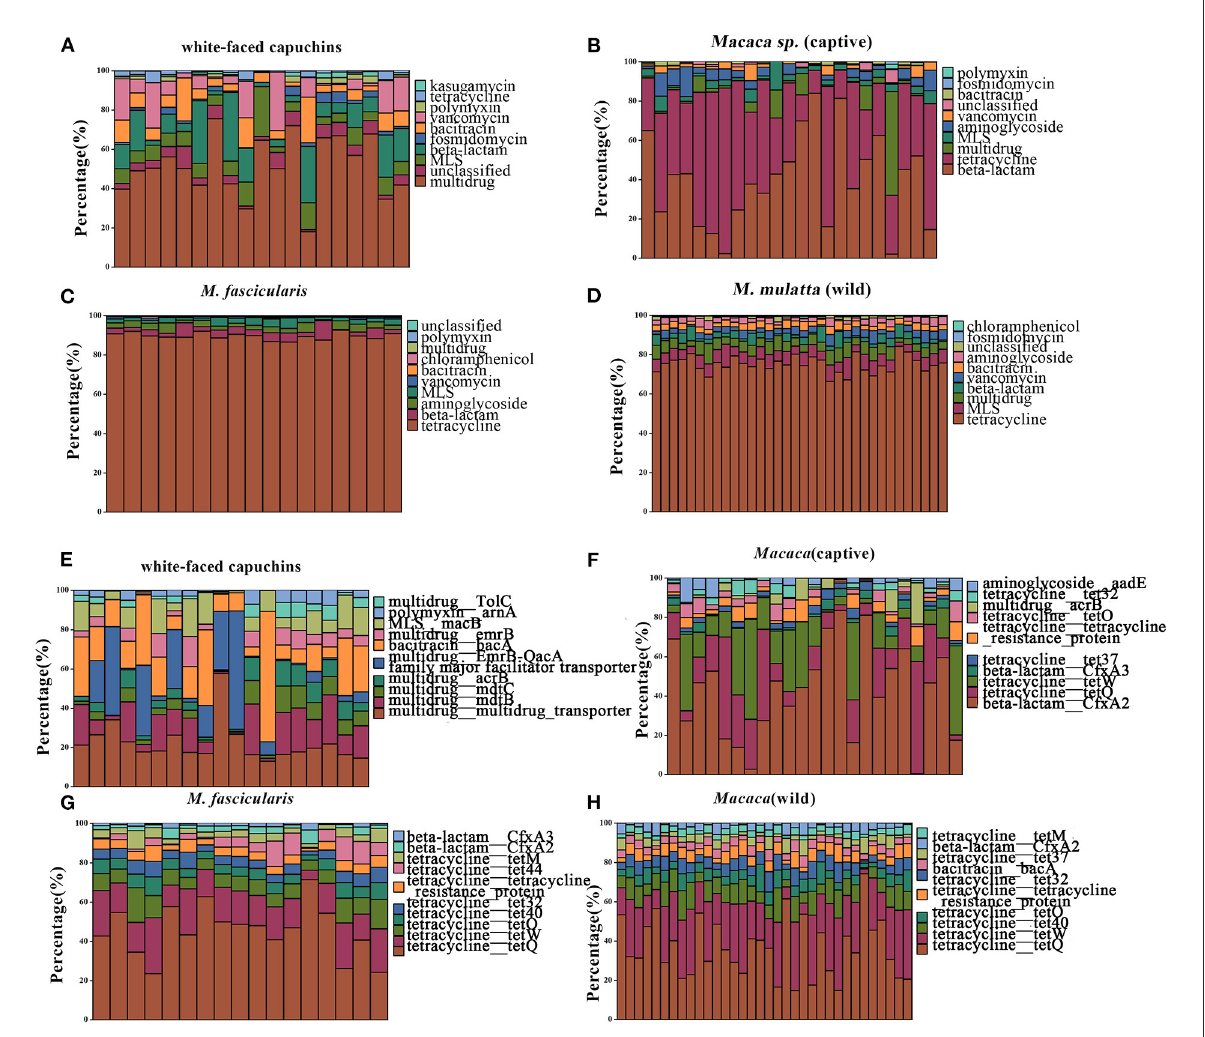
FIGURE4 Relative abundances of top 10 type and subtype ARGs. (A) The top 10 antibiotic resistance class of white-faced capuchins. (B) The top 10 antibiotic resistance class of Macaca sp. (captive). (C) The top 10 antibiotic resistance class of M. fascicularis . (D) The top 10 antibiotic resistance class of M. mulatta (wild). (E) The top 10 antibiotic resistance gene of white-faced capuchins. (F) The top 10 antibiotic resistance gene of Macaca sp. (G) The top 10 antibiotic resistance gene of M. fascicularis . (H) The top 10 antibiotic resistance gene of M. mulatta